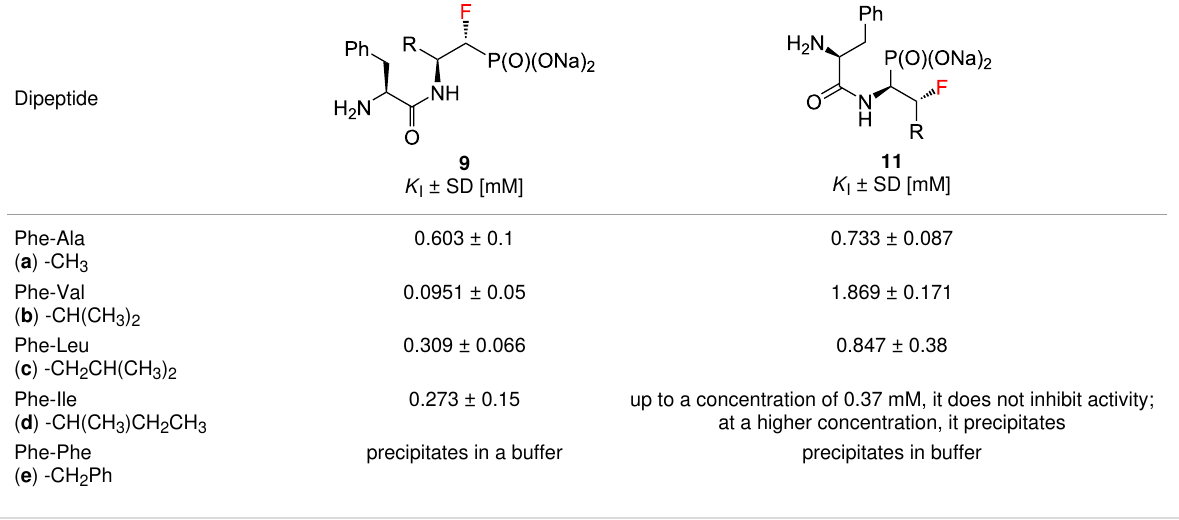
Table 2: Inhibitory constants of the studied of α - and β -fluorinated aminophosphonic acid sodium salts towards bovine cathepsin C.